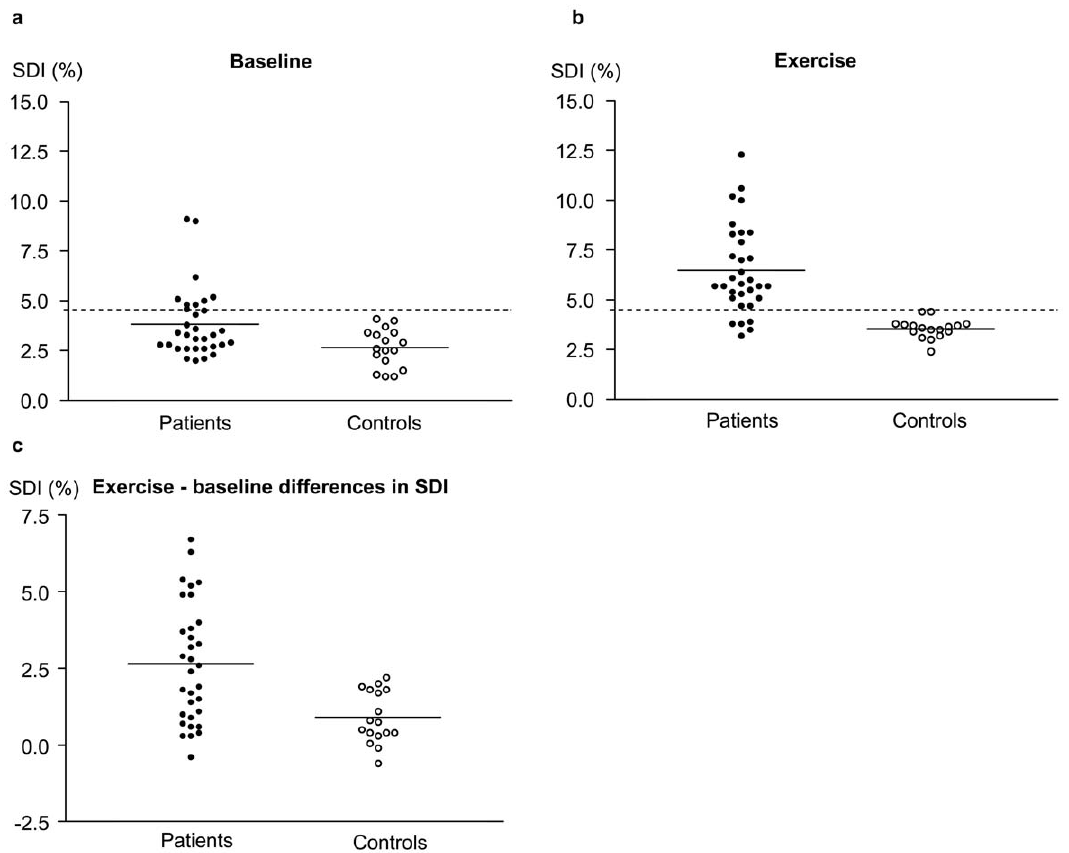
Figure 1. Scatter plots showing (a) baseline left ventricular systolic dyssynchrony index (SDI) at rest, (b) SDI during exercise when target heart rate was reached, and (c) exercise-baseline differences in SDI in patients and controls. Solid horizontal lines represent the mean, while the dotted line represents the upper limit of normal LV SDI.